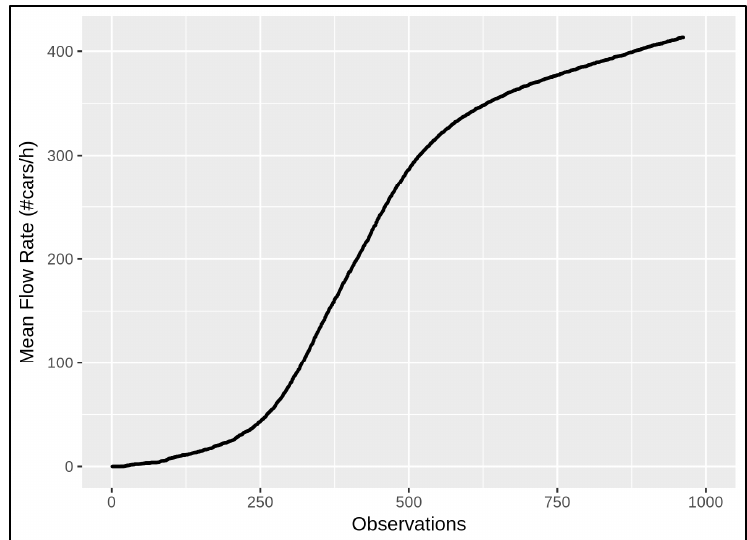
Figure 6. The mean flow rate (MFR) considers traffic observations that are sorted according to increasing travel time measurements in the traffic sensors depicted in Figure 5.